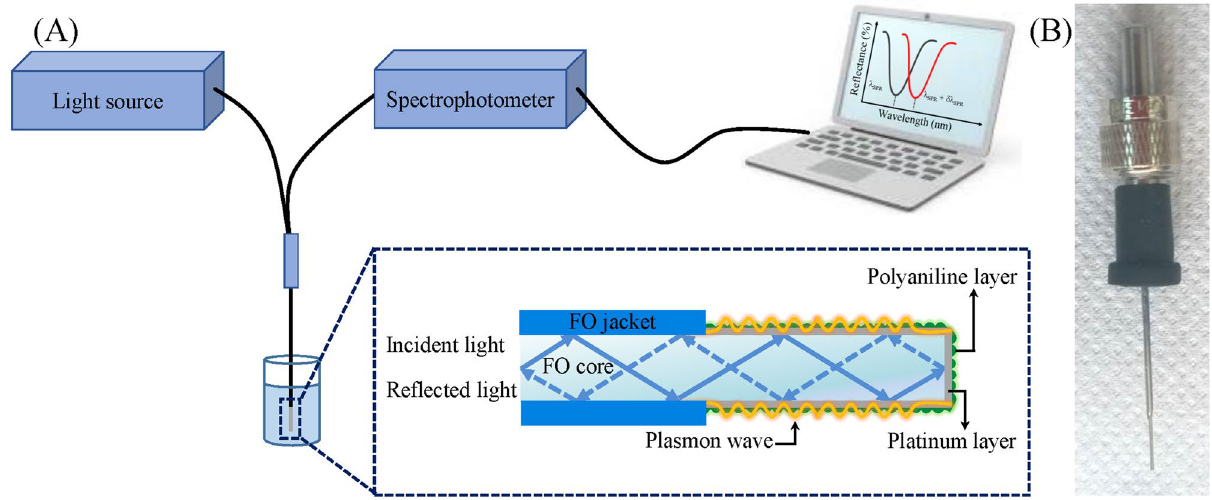
Figure 1. FO-SPR sensing platform. ( A ) Schematic of the experimental setup; ( B ) Image of the fabricated Pt-coated FO-SPR sensor inserted into the SMA connector. Designed using PowerPoint 2016 (Microsoft Office 2016), https:// www. micro soft. com/.